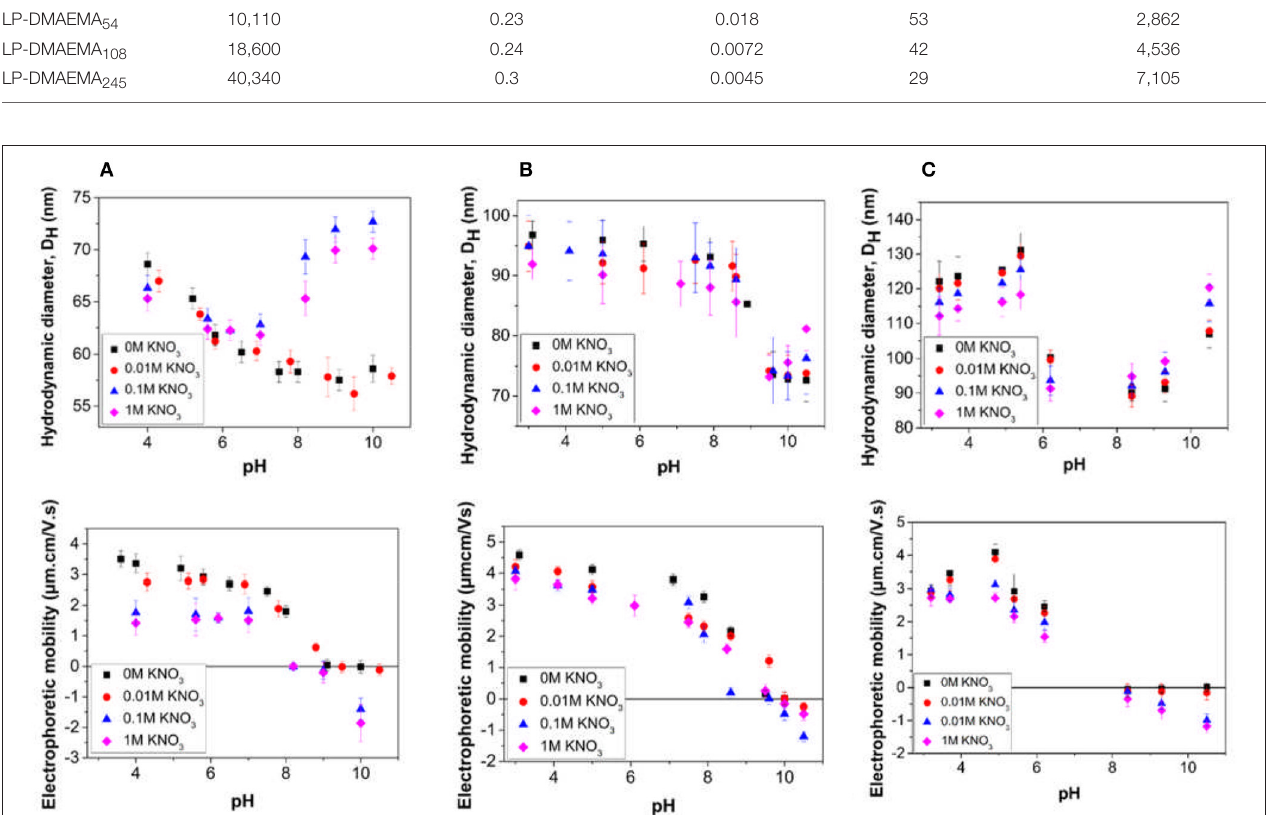
FIGURE 3 | Influence of pH and electrolyte concentration on the properties of particle dispersions obtained from emulsion polymerizations conducted in the presence of the different diblock copolymers (A) LP-DMAEMA 54 , (B) LP-DMAEMA 108 and (C) LP-DMAEMA 245 . Electrolyte concentrations used for the measurements were ( ) 0M (i.e., no added) KNO 3 , ( ) 0.01M KNO 3 , ( ) 0.11M KNO 3 , and ( ) 1M KNO 3